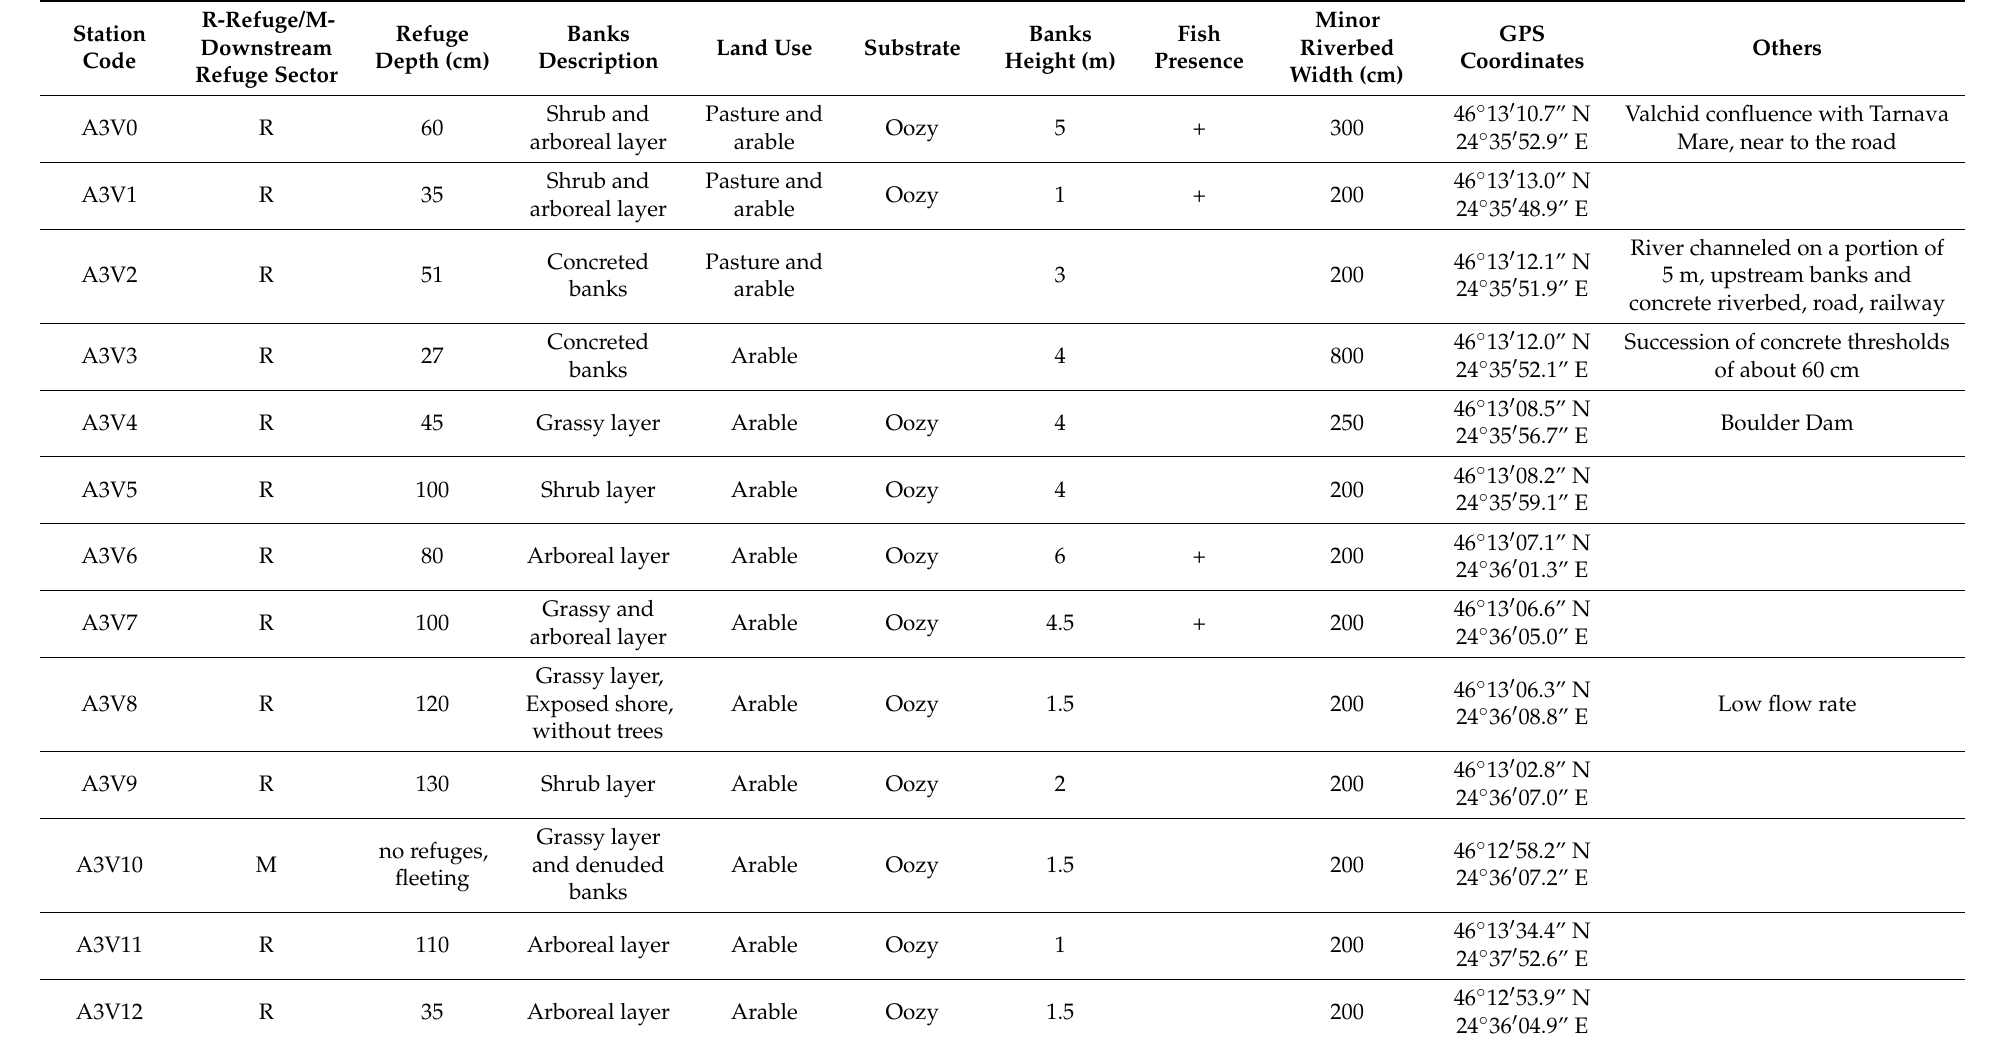
Table A3. Valchid River habitat